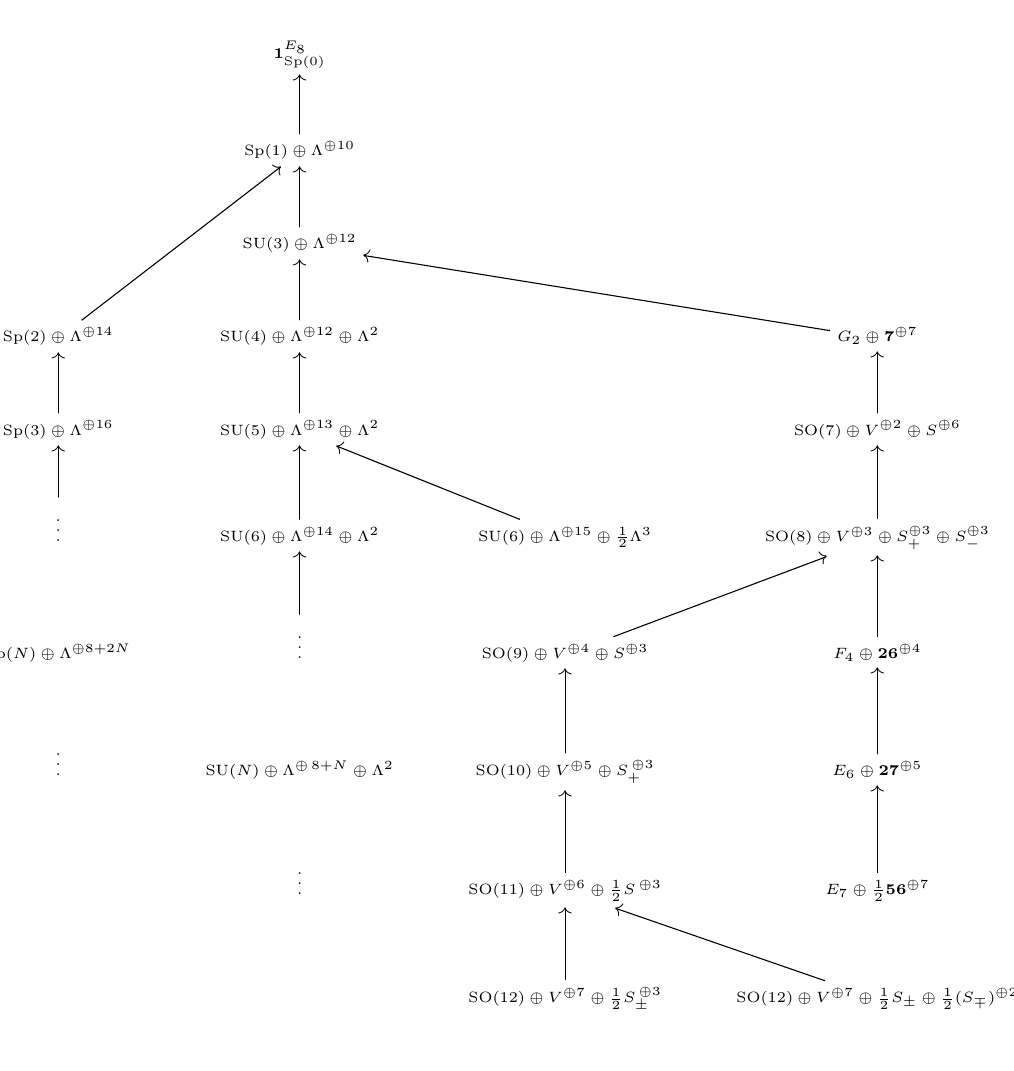
Figure 5. The E-string Higgsing